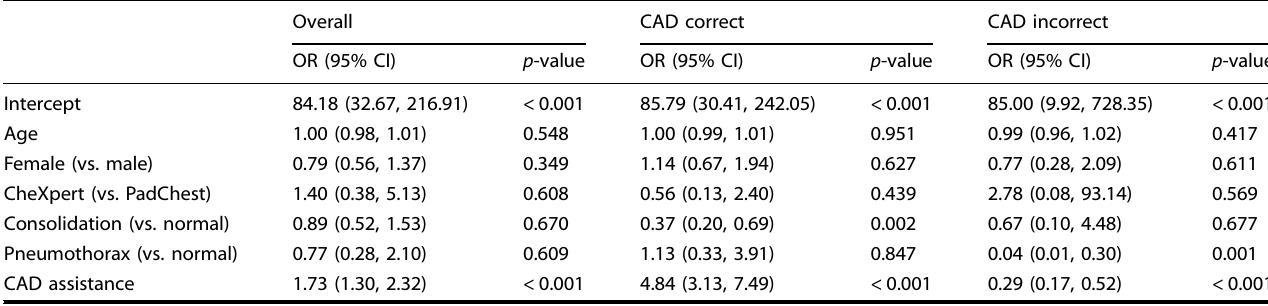
Table 5. Mixed effects logistic regression results for the causal effect of CAD assistance on readers ’ diagnostic accuracy.